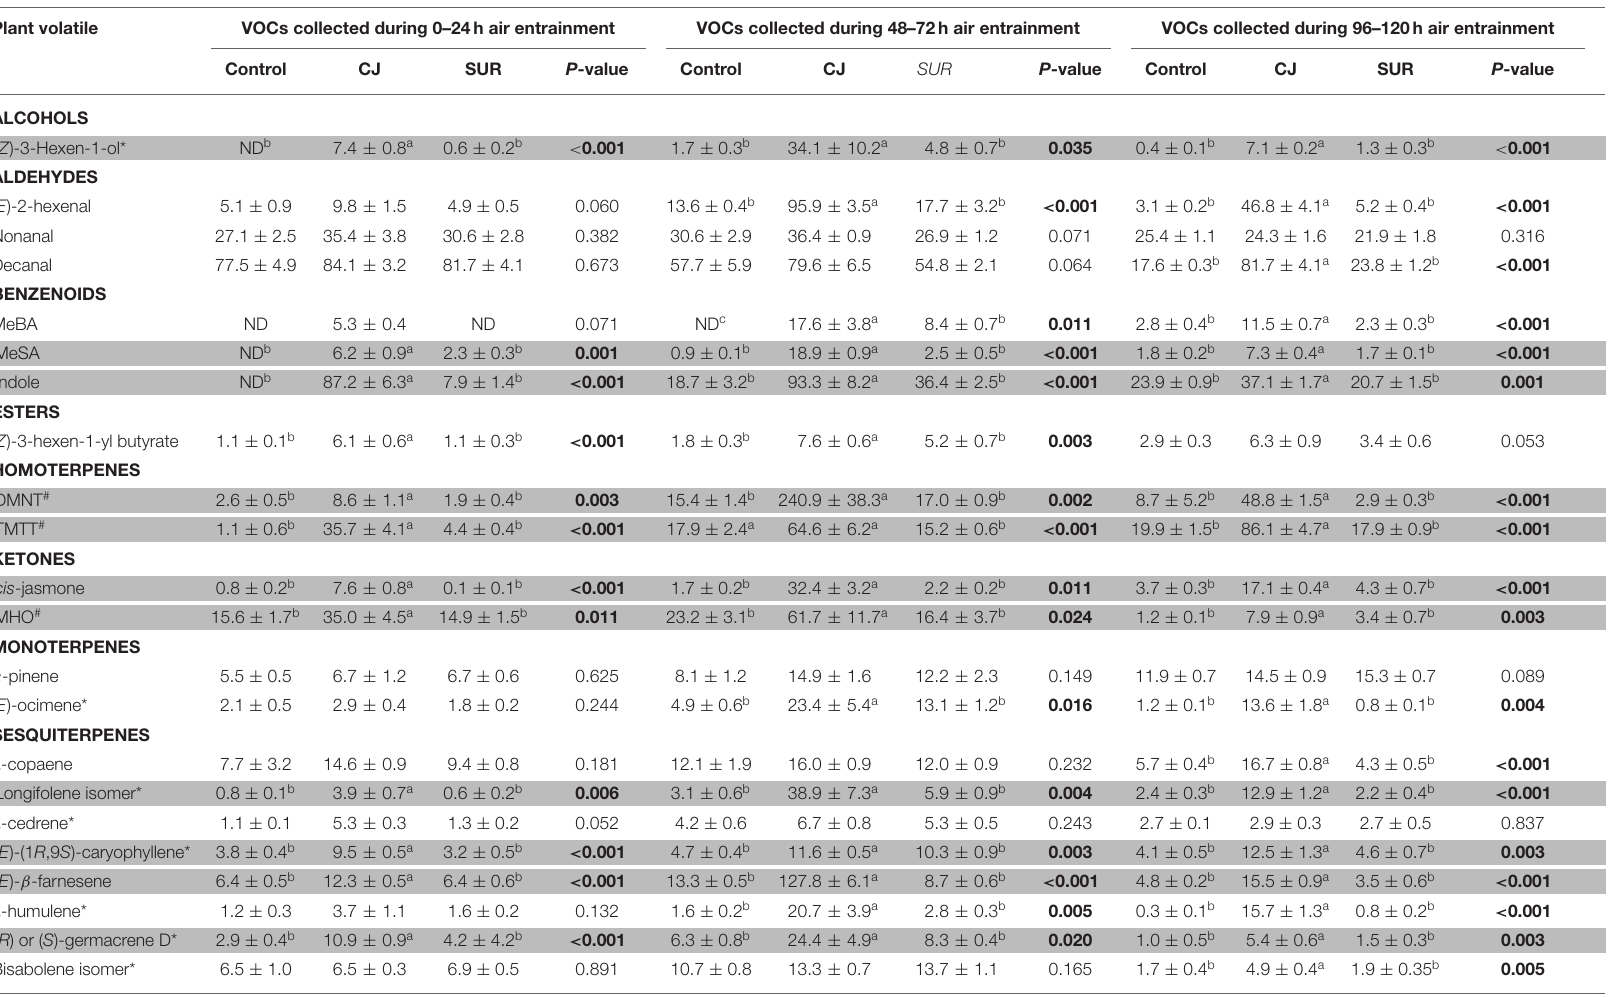
TABLE 2 | Emission (ng ± SE) of volatiles released by cis -jasmone treated (CJ), surfactant-treated (SUR), and non-treated (Intact) potato plants over 24, 72, and 120h air entrainment 1 . Plant